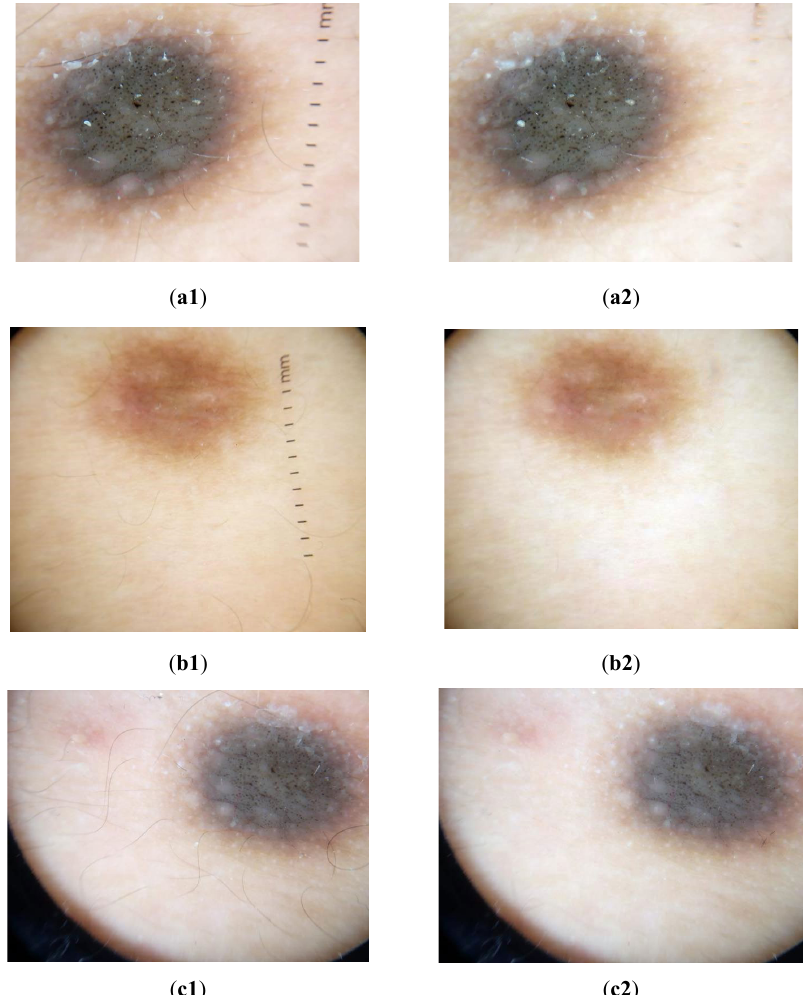
Figure 5. Samples of clinical images before and after applying the proposed hair removal method, where ( a1 – c1 ) images before hair removal and ( a2 – c2 ) images after hair removal method.